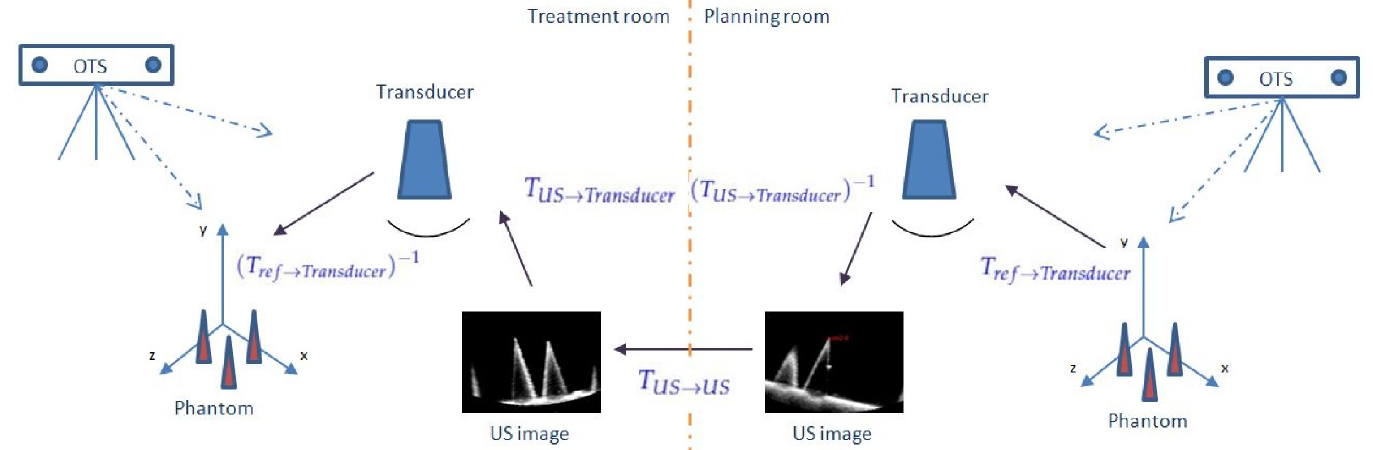
Fig 10. Full transformation chain from the planning to the treatment